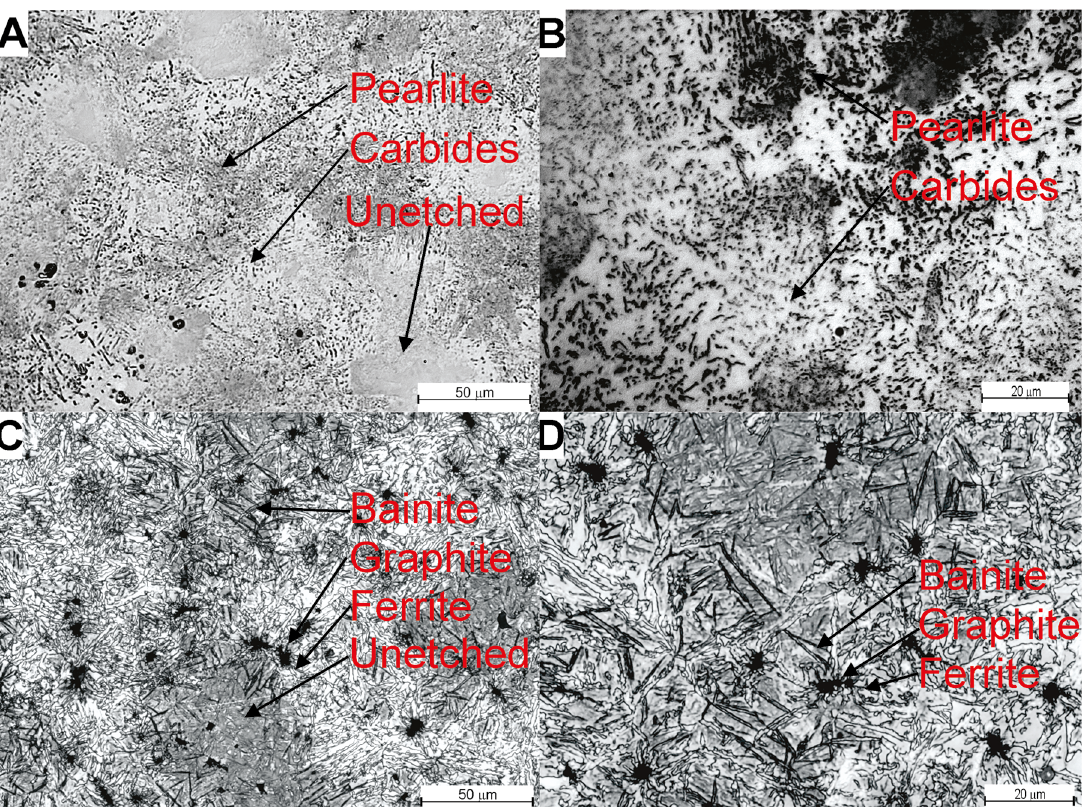
Figure 1. Optical microscopy of the sintered samples corresponding to: (A) and (B) Base alloy, (C) and (D) Base alloy + 3 %